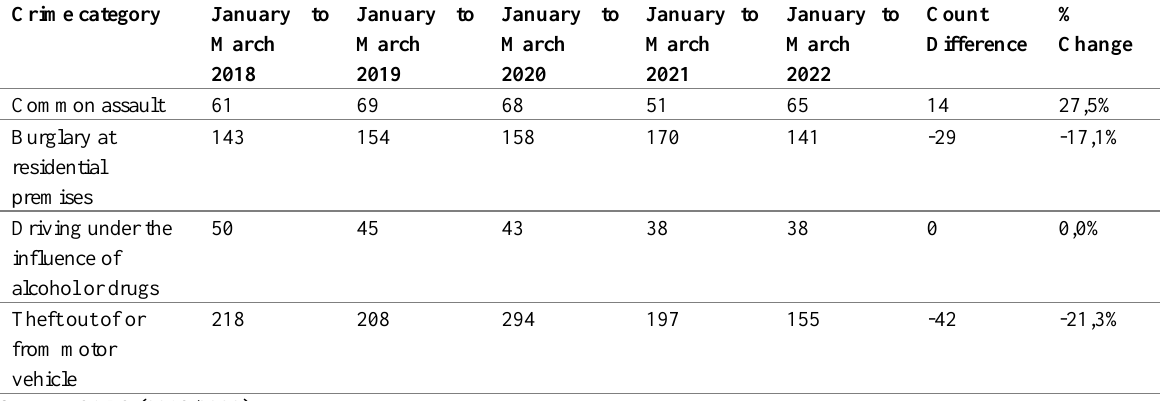
Table 2: Fourth Quarter Crime Statistics 2021/2022 of Brooklyn police